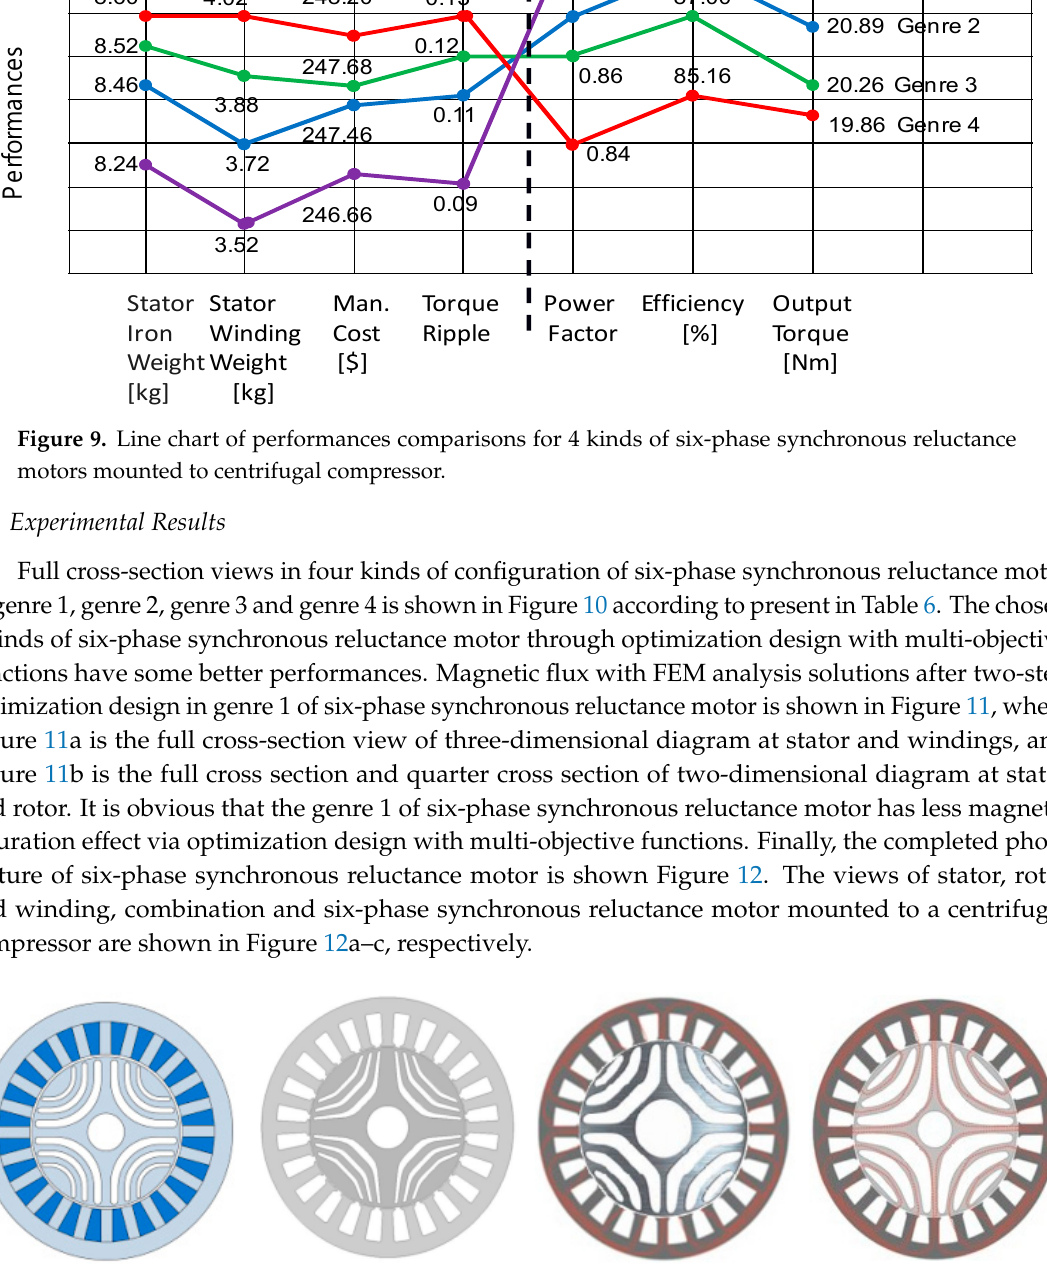
Figure 8. Line chart of comparisons of torque ripple for 4 kinds of six-phase synchronous reluctance motors mounted to centrifugal compressor with various speeds.